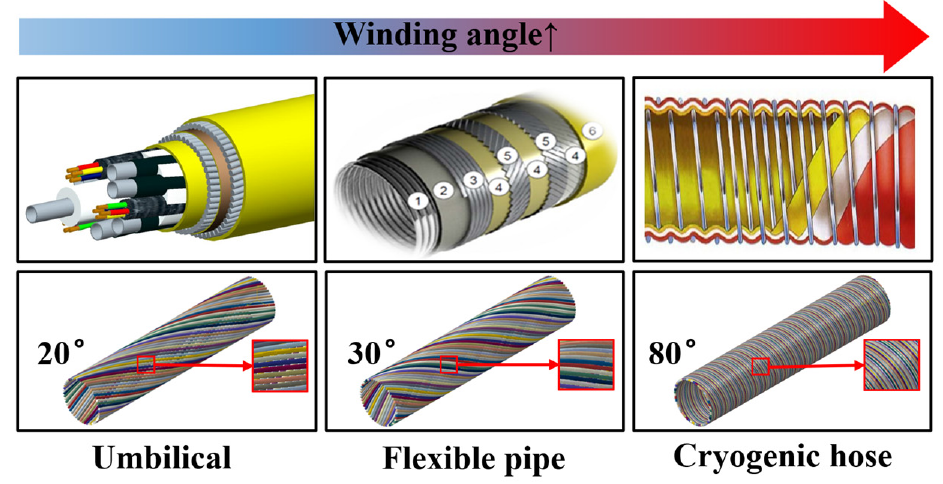
Figure 10. Three pipe/cables winding angles.